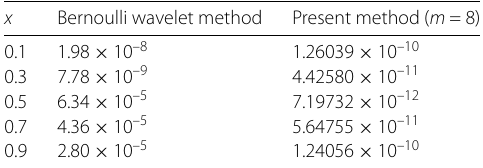
Table 1 The comparison of the absolute errors with Bernoulli wavelet method on the interval [0,1]